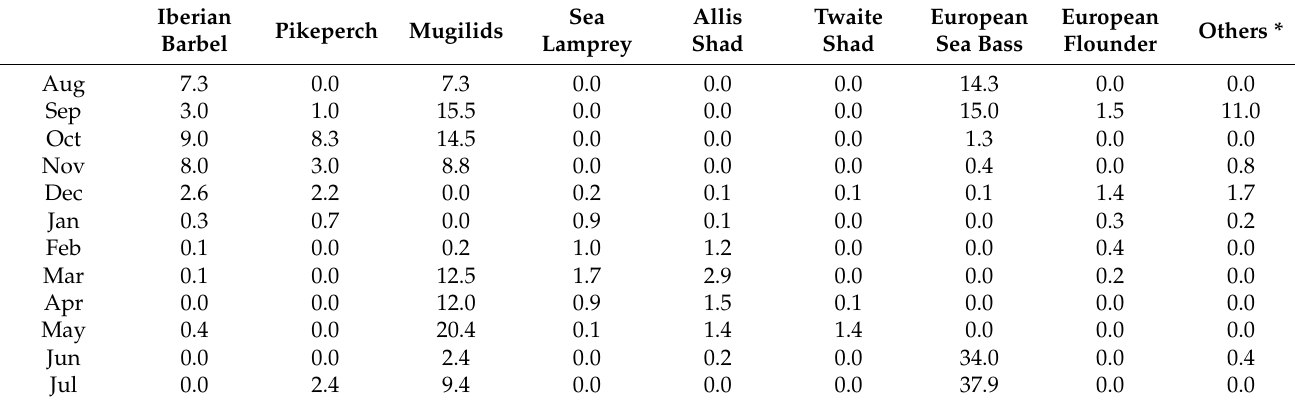
Figure 5. Proportion of the monthly total catch (number of individuals) represented by the different species caught downstream of the Crestuma-Lever dam from August 2016 to July 2017 (European eel is not included as its catches were reported in weight). Table 6. Average catch (ind.fishing day − 1 ) by fisherman downstream of the Crestuma-Lever dam from August 2016 to July 2017 (* including bleak, largemouth bass, Eurasian carp, Atlantic salmon and two-banded seabream, Diplodus vulgaris ).